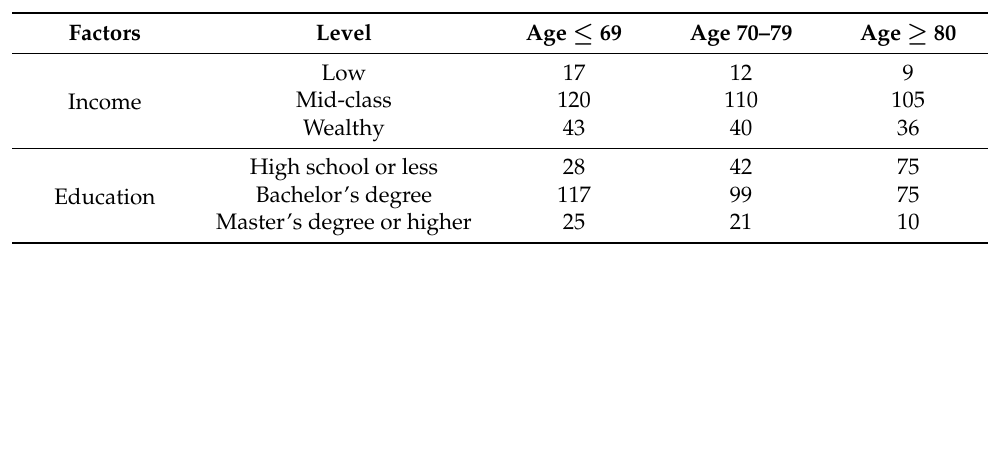
Table 1. Sample distribution based on sociodemographic